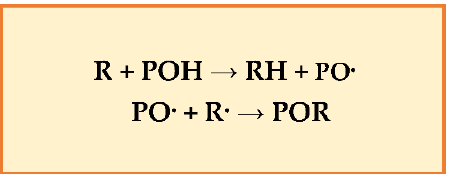
Figure 2. Reactions between lipids and phenols.